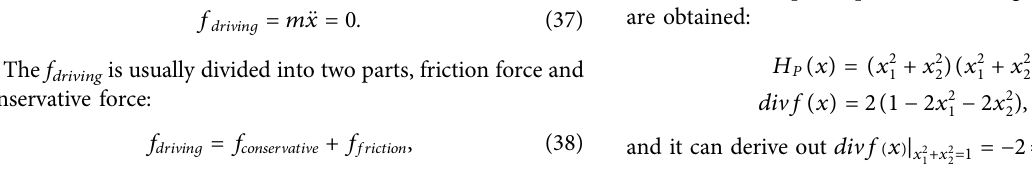
TABLE 2 | The H p and divf of the planar linear system with four Jordan ’ s normal forms as a coef fi cient matrix. div f / H P Jordan ’ s normal